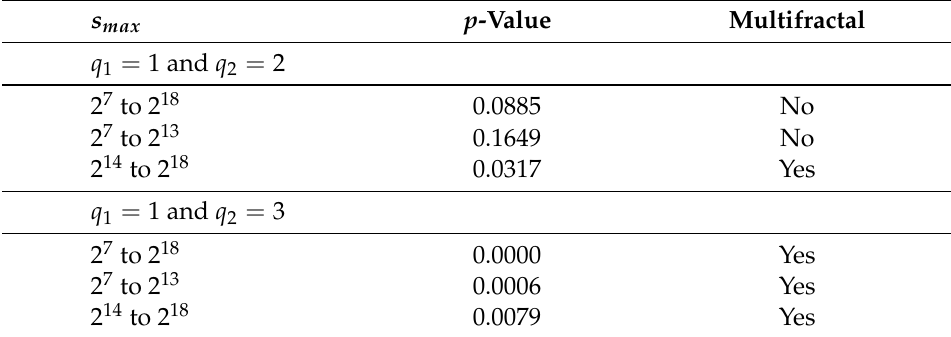
Table 4. Multifractality Wilcoxon rank-sum test for the full sample.